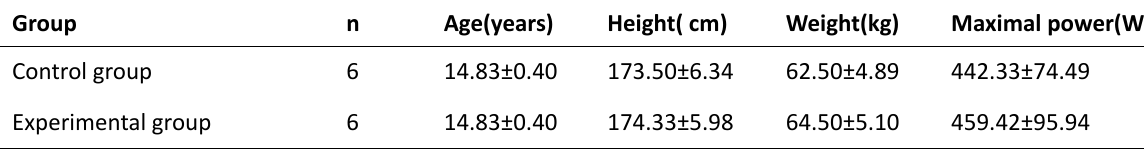
Table 2: Comparison of pre-test and post-test in experimental group 0.9459.16±70.19448.33±85.51379.17±51.8LDH